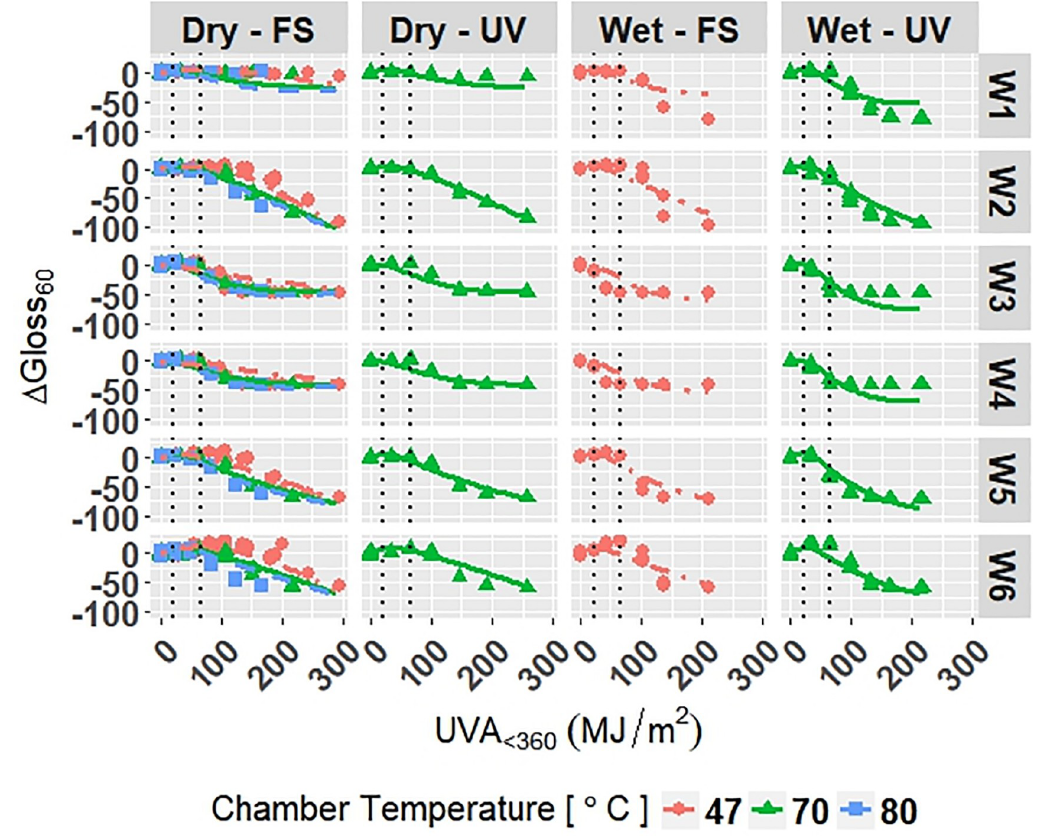
Fig 10. The change in Δ Gloss 60 for white grades of PET under accelerated exposures with the model curves superimposed on the data. Points represent the measured data and solid and dashed lines represent the models. Vertical, dotted lines represent the location of natural spline knots.